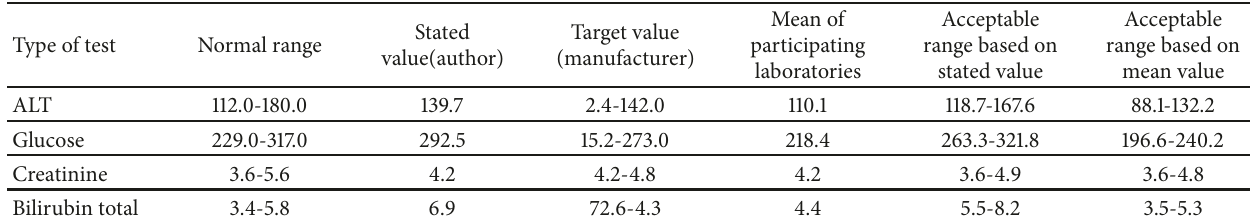
Table 3: Normal range, stated value, target value (manufacturer), mean of participating laboratories, and acceptable values based on TEa ± 20%, ± 10%, ± 15%, and ± 20 for each analytes ALT, glucose, creatinine, and total bilirubin, respectively,from Humatrol P control sample given in IU/L and mg/dl.